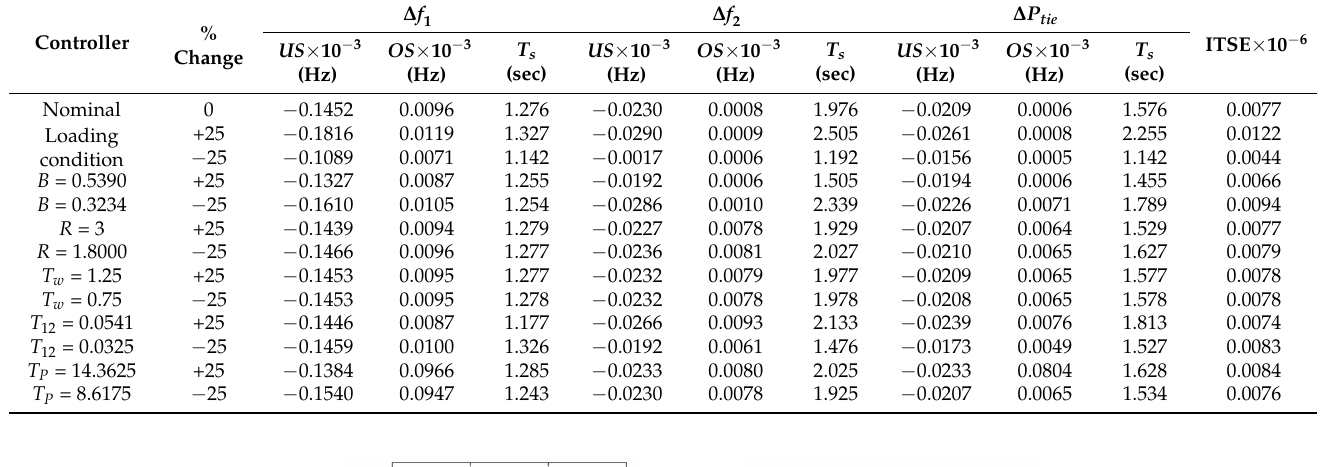
Table 4. Frequency deviation and tie-line power deviation under sensitivity analysis.